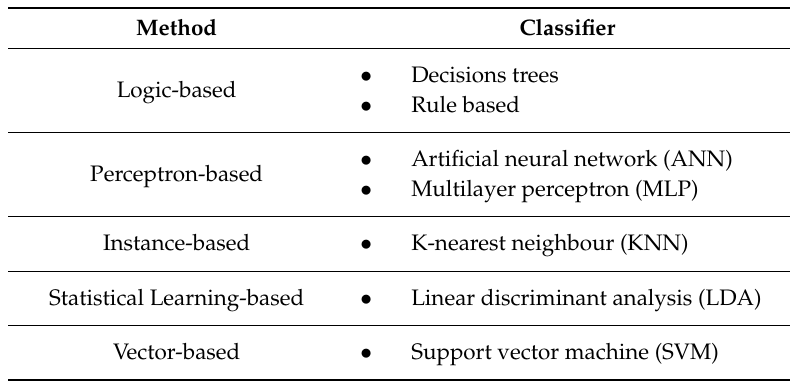
Table 8. Methods for supervised machine